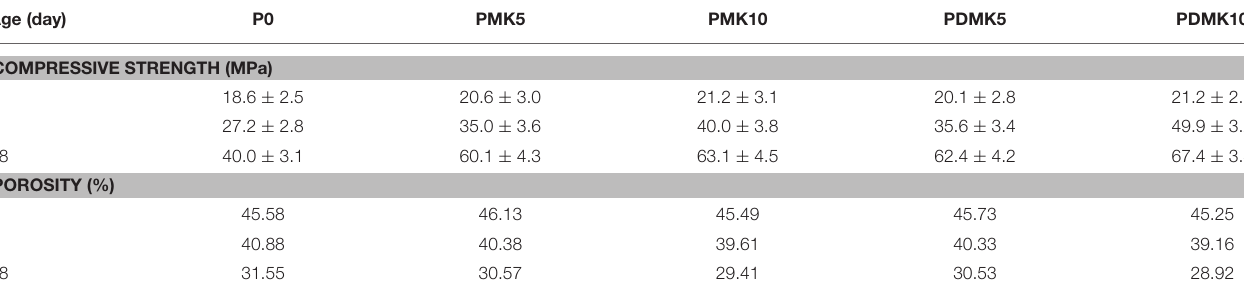
TABLE 7 | Compressive strength with standard deviation and porosity of paste specimens. Age (day) P0 PMK5 PMK10 PDMK5 PDMK10